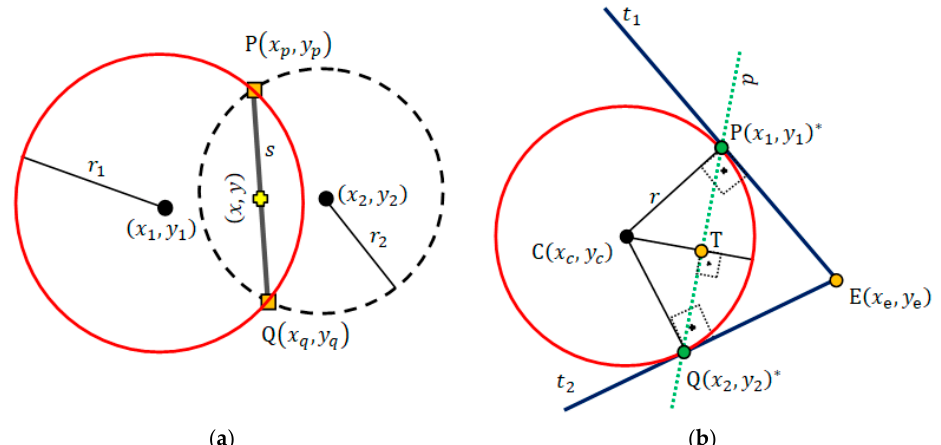
Figure 1. ( a ) Analytical solution to ( x , y ) when there is an intersection between circles. ( b ) Possible tangential straight lines t 1 and t 2 for the circle line obtained by an external point E ( x e , y e ) (pole-point). Polar-line p and its geometric relationship with the tangent lines and a given conic section (circle in this case).